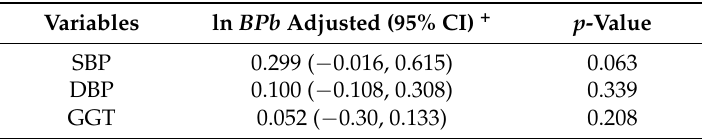
Table 2. Associations between BLLs and cardiovascular-related markers of interest in individuals exposed to military environments.